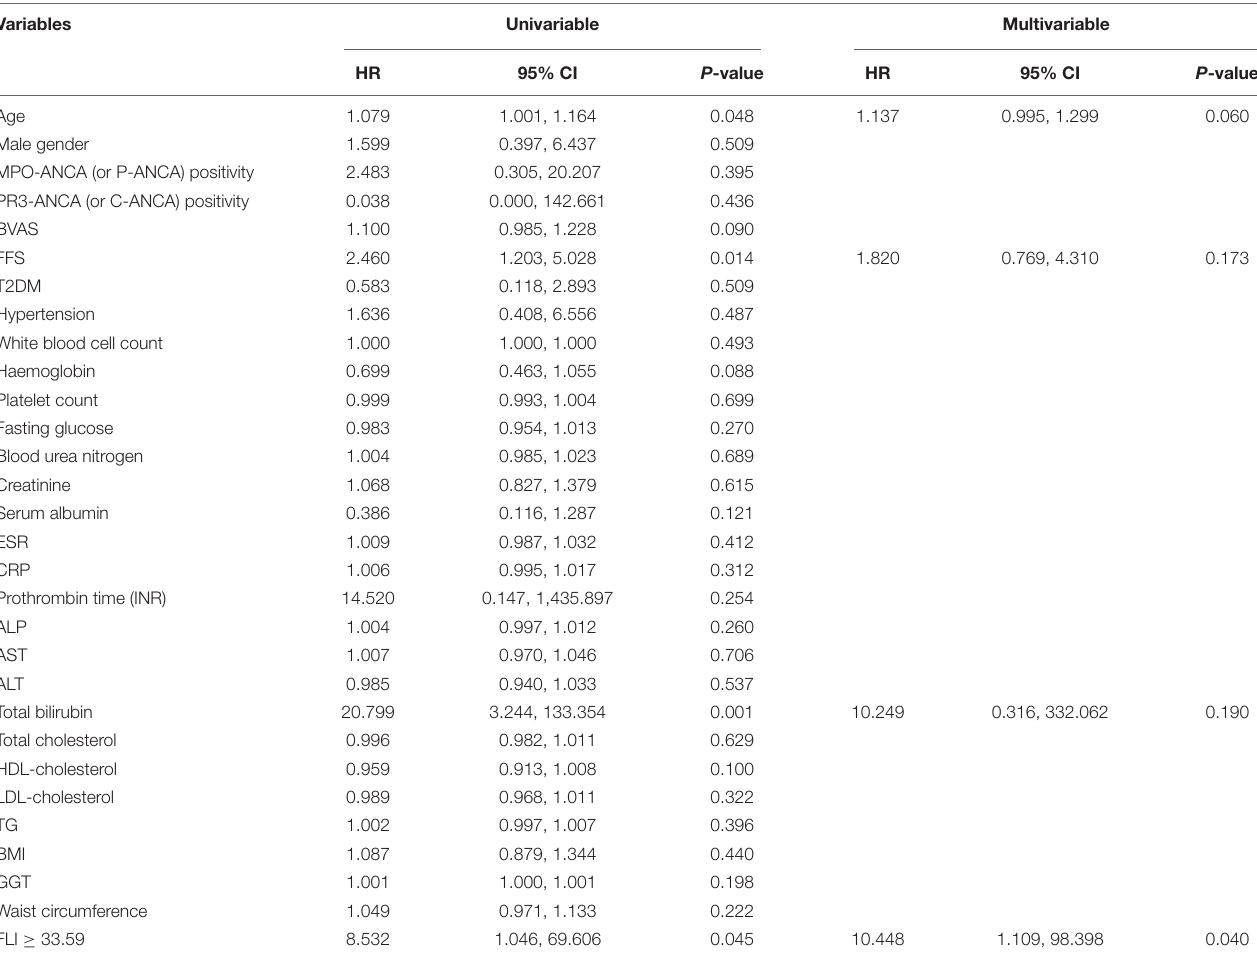
TABLE 3 | Cox hazards model analyses of variables at AAV diagnosis for all-cause mortality during follow-up in AAV patients. Variables